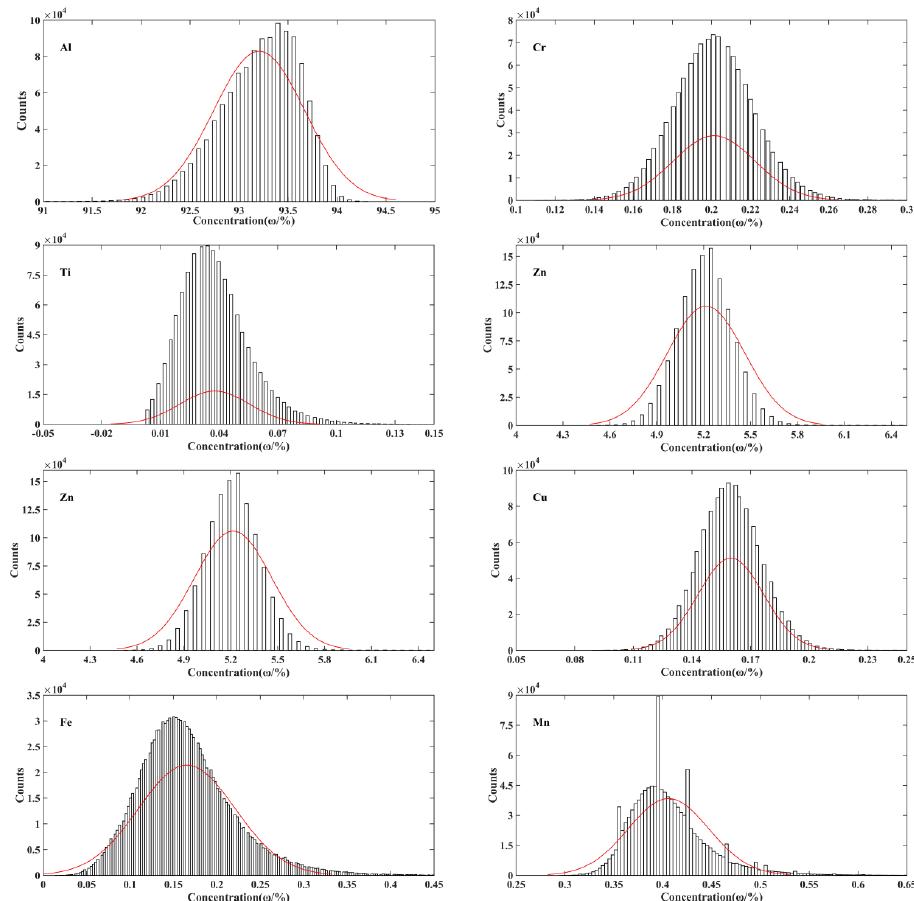
Figure 8. The frequency distribution histogram of element content in the 7B05 aluminum alloy.